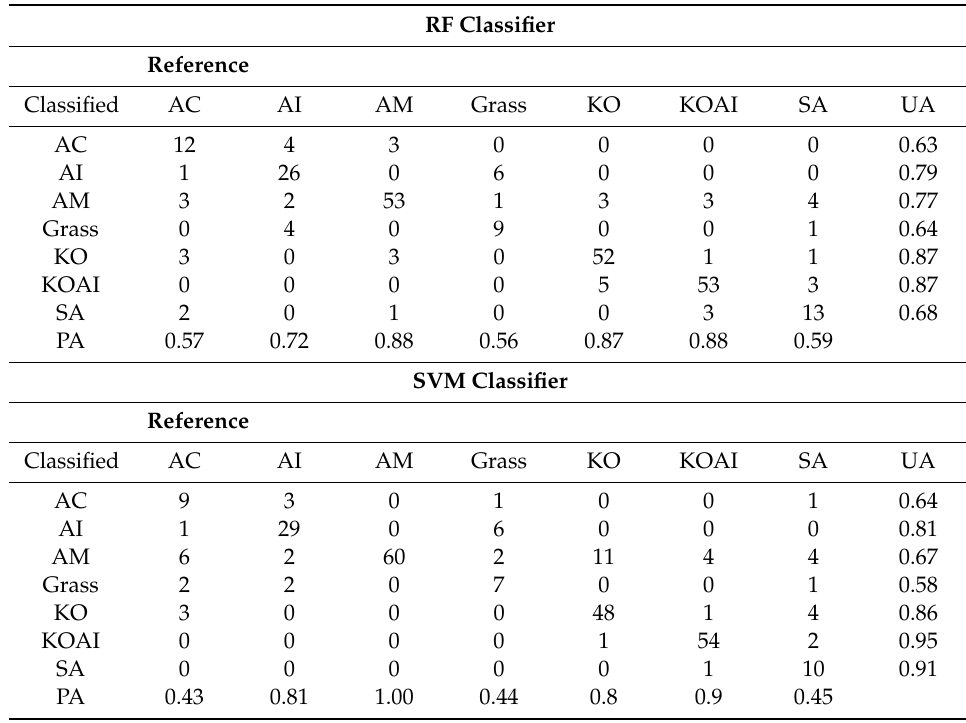
Table 5. Confusion matrix for classification with LiDAR